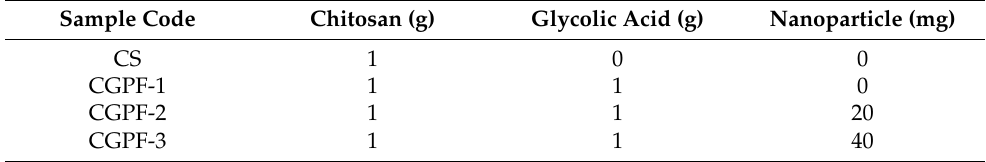
Table 1. The formulation of glycolic acid-grafted chitosan with hybrid nanoparticles. Sample